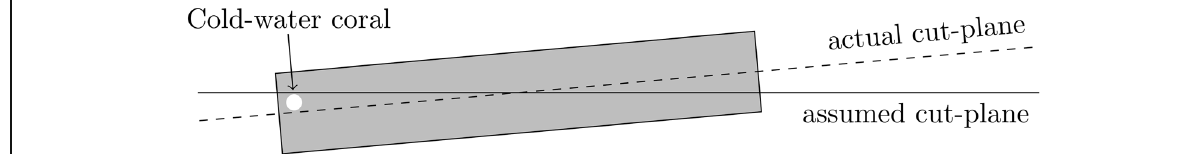
Fig. 2 Schematic example of the effect of core misalignment on core sampling planning (coronal plane, not to scale). When calculating sagittal reconstructions, misalignment might lead to a misrepresentation of sample locations (see also Fig. 6). In consequence, samples might be missed and other samples might be destroyed during the sampling